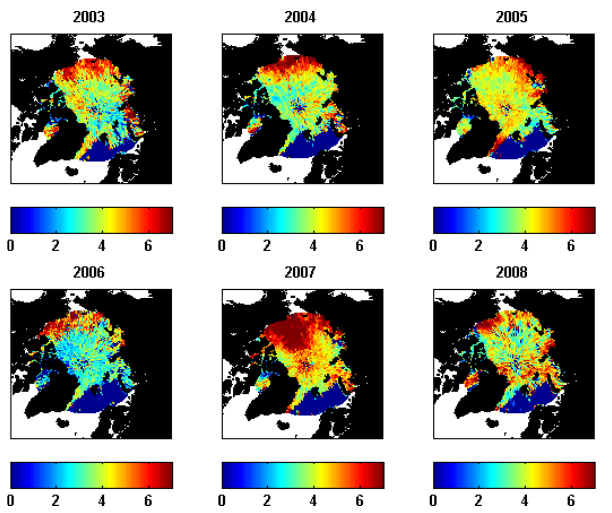
Fig. 9. Same as in Fig. 7, but for the month of August.